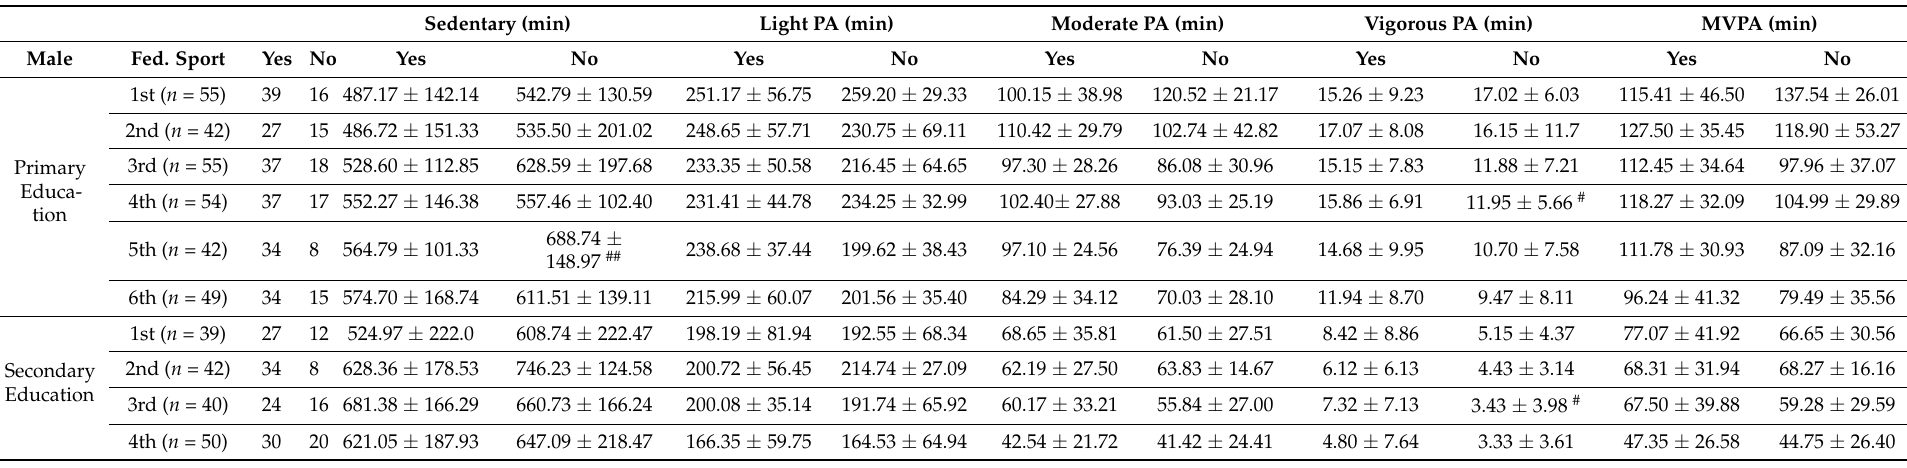
Table 5. Results of the daily physical activity levels and sedentary behavior in each of the school years between practitioners and nonpractitioners of organ- ised/federated sports in each